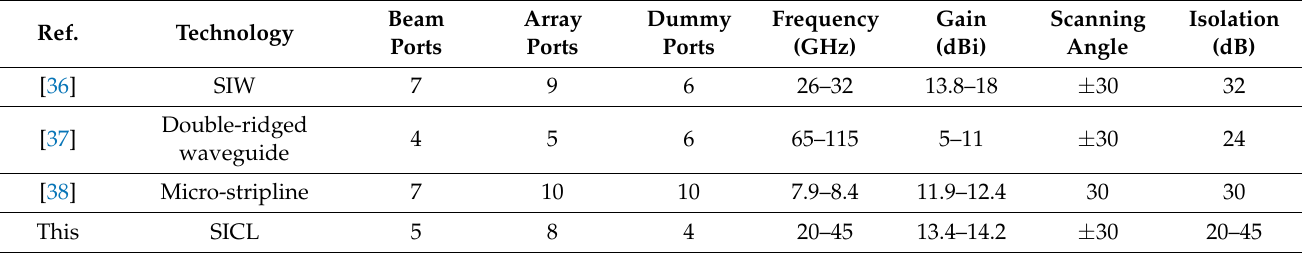
Table 1. Comparison with RLs developed with other technologies.